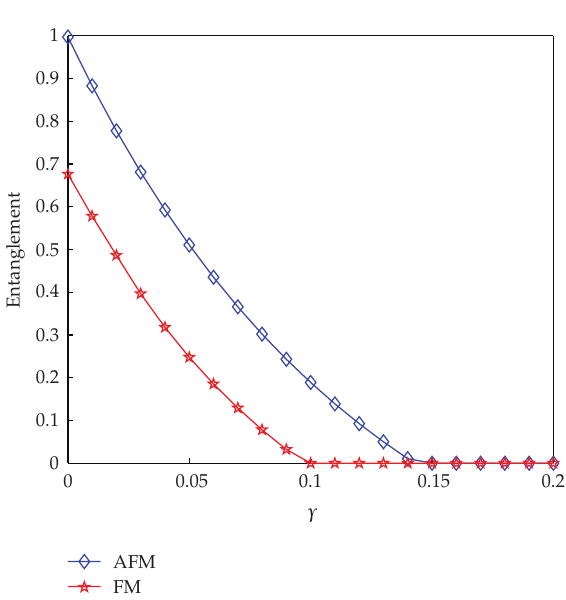
Figure 4: (cid:4) Color online (cid:5) The amount of entanglement in its first maximum between two ends in a chain of length 6 versus the decoherence parameter γ in a fully polarized environment for both the case of FM chain and AFM